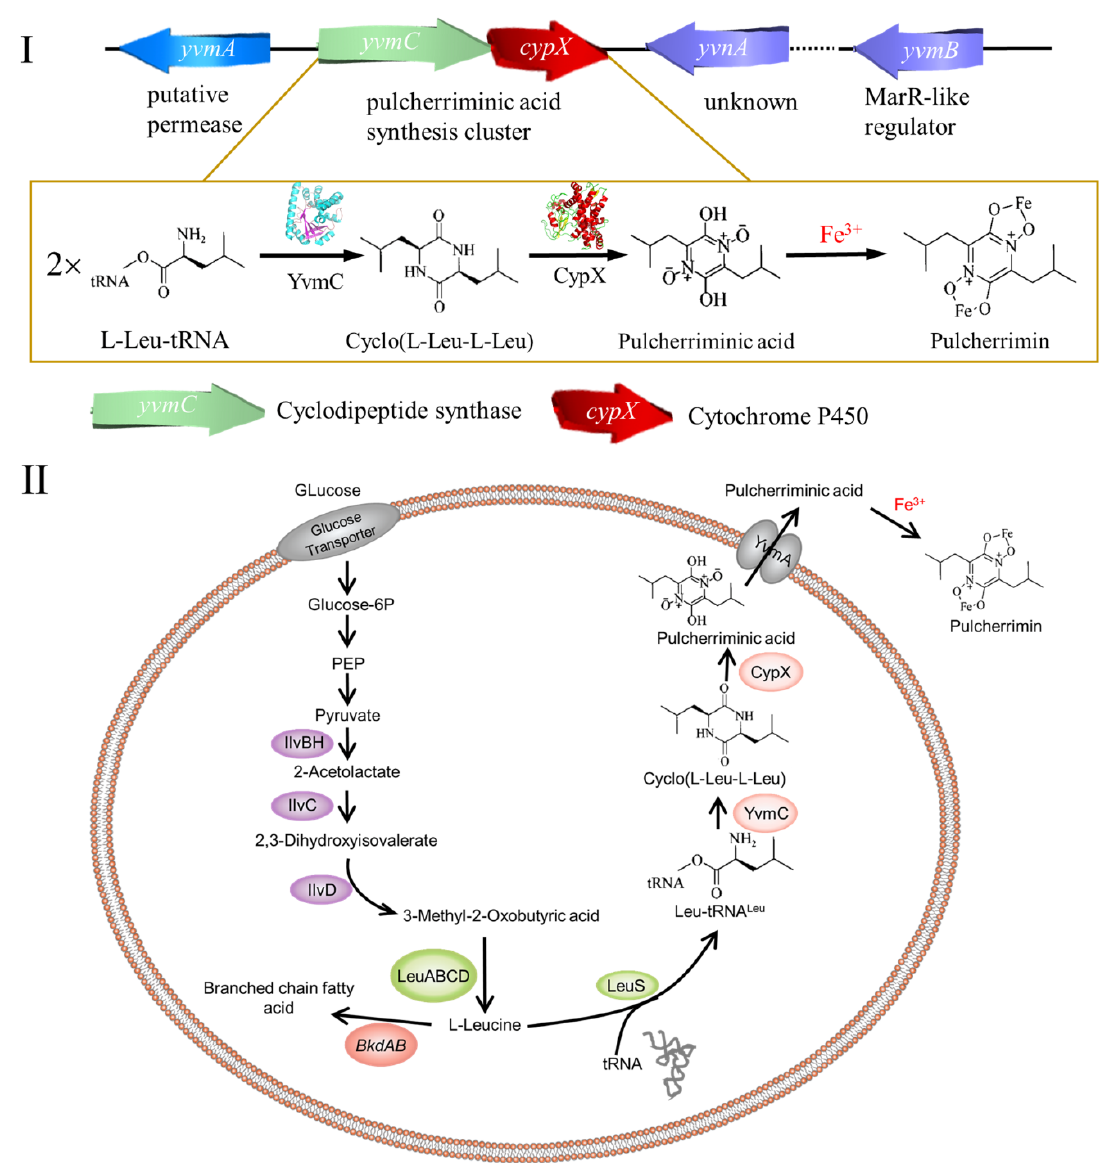
Figure 2. The gene cluster ( I ) and synthetic pathways ( II ) of pulcherriminic acid and pulcherrimin in B. subtilis [19].